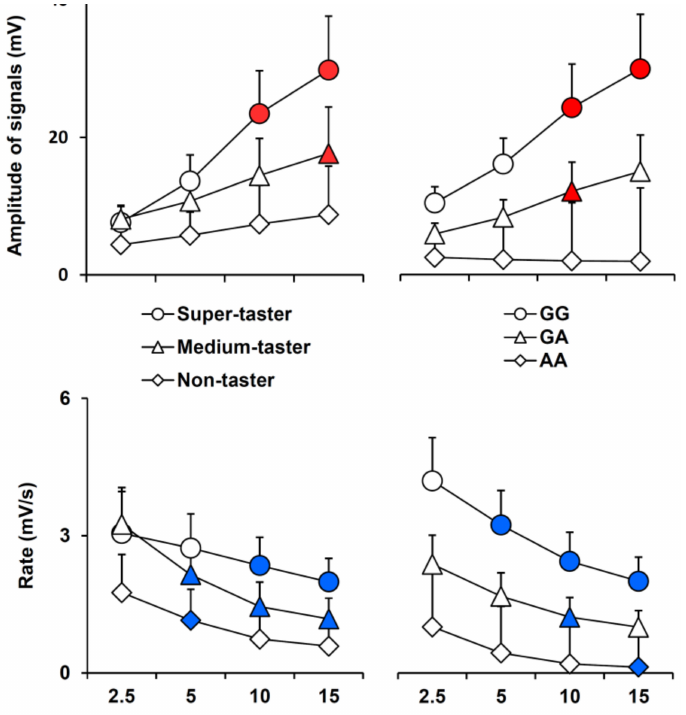
Figure 6. Time course of amplitude (mV) or hyperpolarization rate (mV/s) of the signal across PROP taster status or CD36 polymorphism groups during stimulation time. Data (mean values ± SEM) are determined after 2.5, 5, 10, and 15 s from the application of oleic acid (30 µ L). n = 10 super-tasters, n = 13 medium tasters and n = 12 non-tasters; n = 9 volunteers with genotypes GG in CD36, n = 20 GA genotypes and n = 6 AA genotypes. Solid symbols (red for amplitude of signals and blue for rate) indicate a significant difference with respect to the previous value of the corresponding group ( p ≤ 0.05; Fisher LDS or Duncan’s test, subsequent to repeated measures ANOVA across PROP taster groups or CD36 genotype of